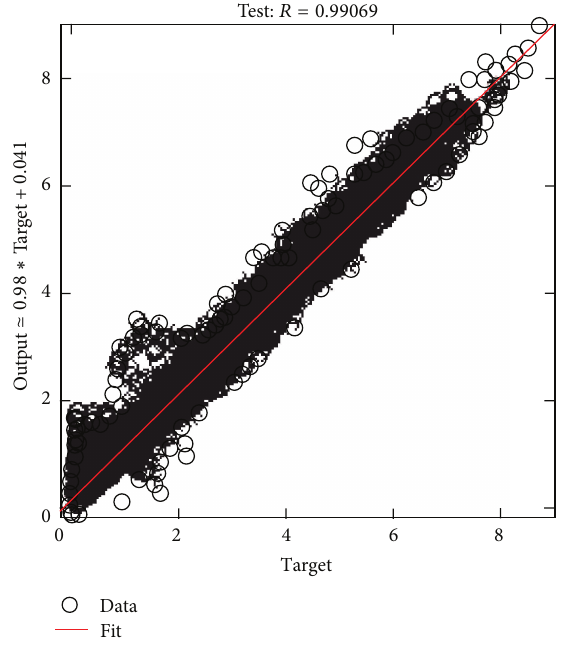
Figure 10: Test correlation coefficient.